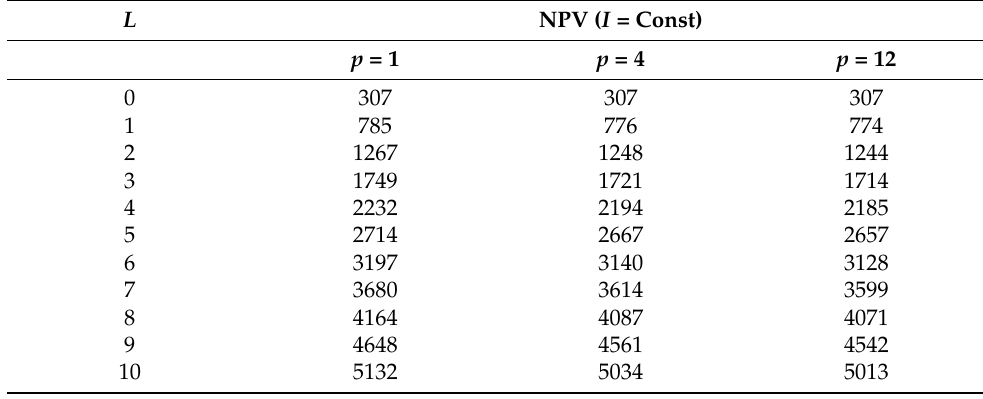
Table 6. Change of net present value, NPV, with leverage, L , for k d = 0.14; k 0 = 0.22; p = 1, 4, and 12; and n =